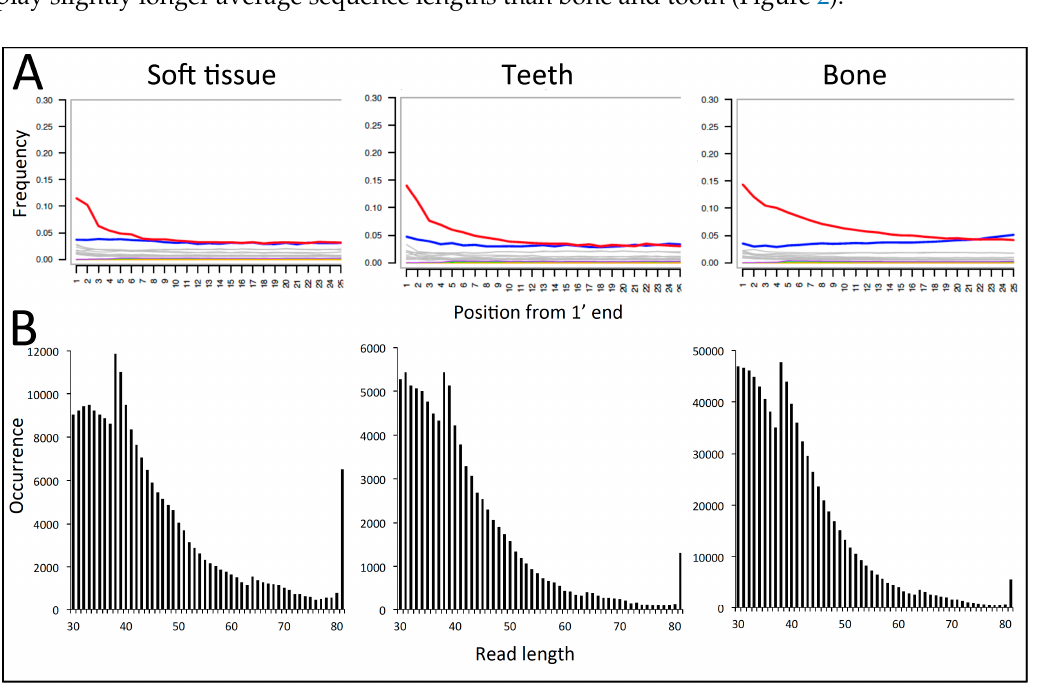
Figure 2. DNA damage based on shotgun sequencing data of three types of tissue (soft tissue, tooth, bone) obtained from the same historical Z. longissimus individual (ZMUC R8974), and using T. sirtalis as reference genome in the mapping. A : C to T deamination damage (red line) recorded at each position in the read from the 5 ′ end of the molecules (output from mapDamage). B : The mapped read